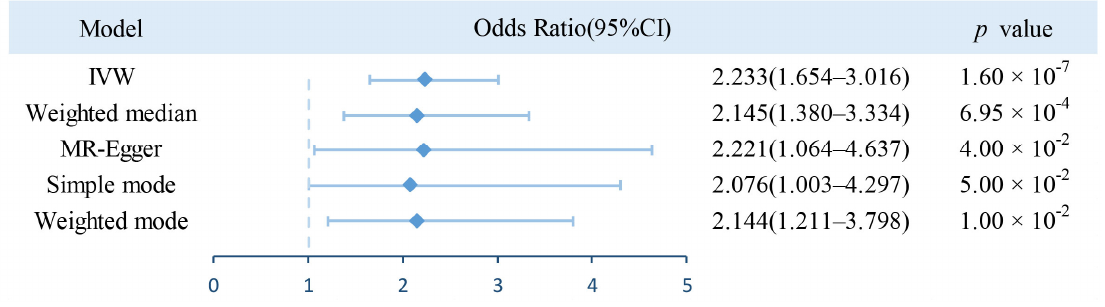
Figure 4. Risk of whole body water mass for genetically predicted atrial fibrillation. IVW, inverse variance weighted.